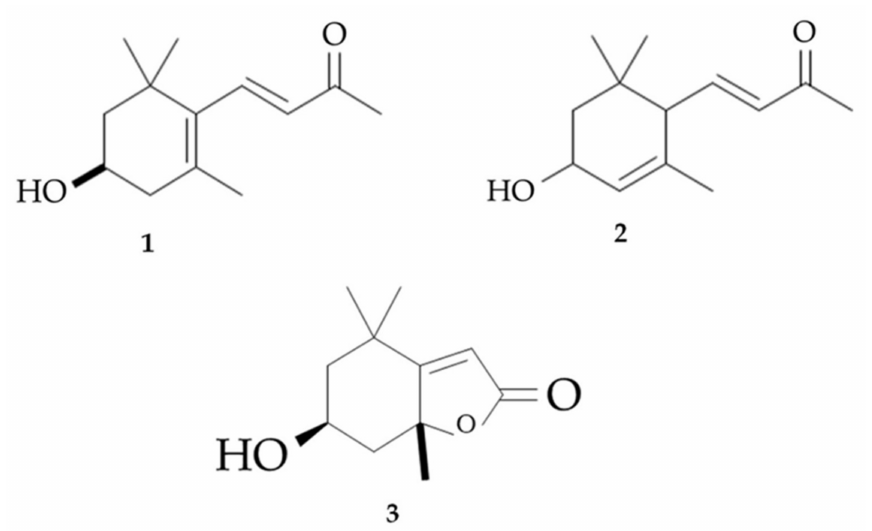
Figure 2. The molecular structure of the characterized allelopathic compounds from Elaeocarpus floribundus leaf extracts: 1 . (3 R )-3-hydroxy- β -ionone, 2 . cis -3-hydroxy- α -ionone, 3 .